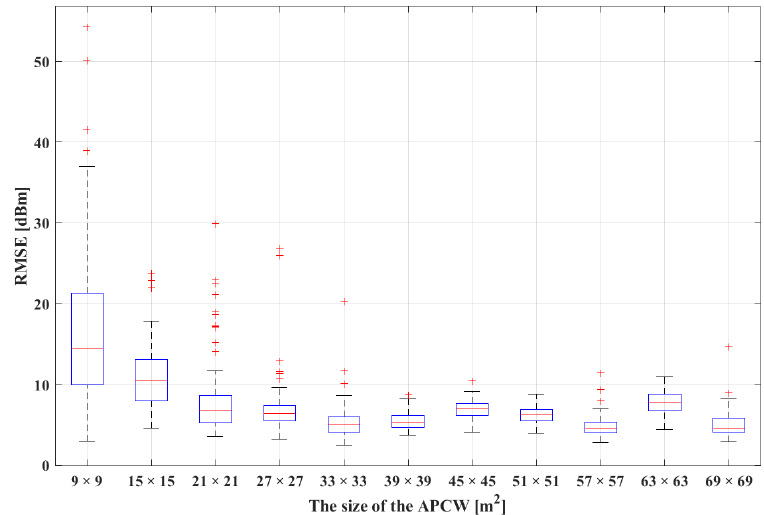
Figure 11. Boxplot of the RMSE distribution between the real and RGN-generated AP radio-maps by different APCW sizes.